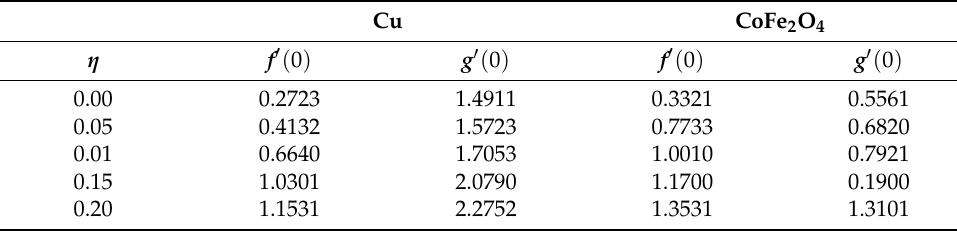
Table 4. The relative assessment of Cu and cobalt ferrite nanoparticulate on skin friction.